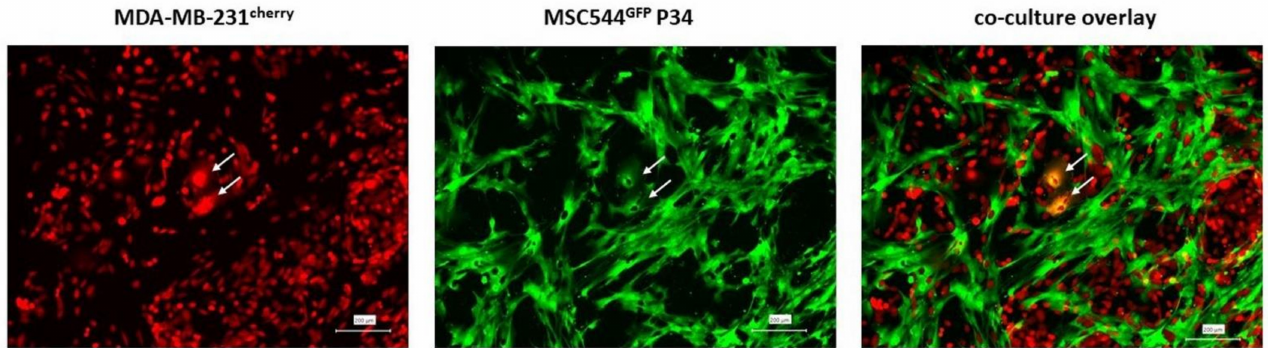
Figure 1. Cancer-cell fusion in vitro. Cancer-cell fusion of cherry-labeled human MDA-MB-231 breast-cancer cells ( left panel) with the GFP-labeled human MSC544 cell line in P34 ( middle panel) was detectable following a 4 day co-culture similar to previous experimental approaches [45]. Two evolving breast-cancer hybrid cells became detectable after spontaneous fusion (white arrows), which simultaneously expressed the cherry ( left panel) and GFP genes ( middle panel) in a fluorescence overlay by displaying a yellow color ( right panel). Bars represent 200 µ m using a BZ-X800 Keyence fluorescence